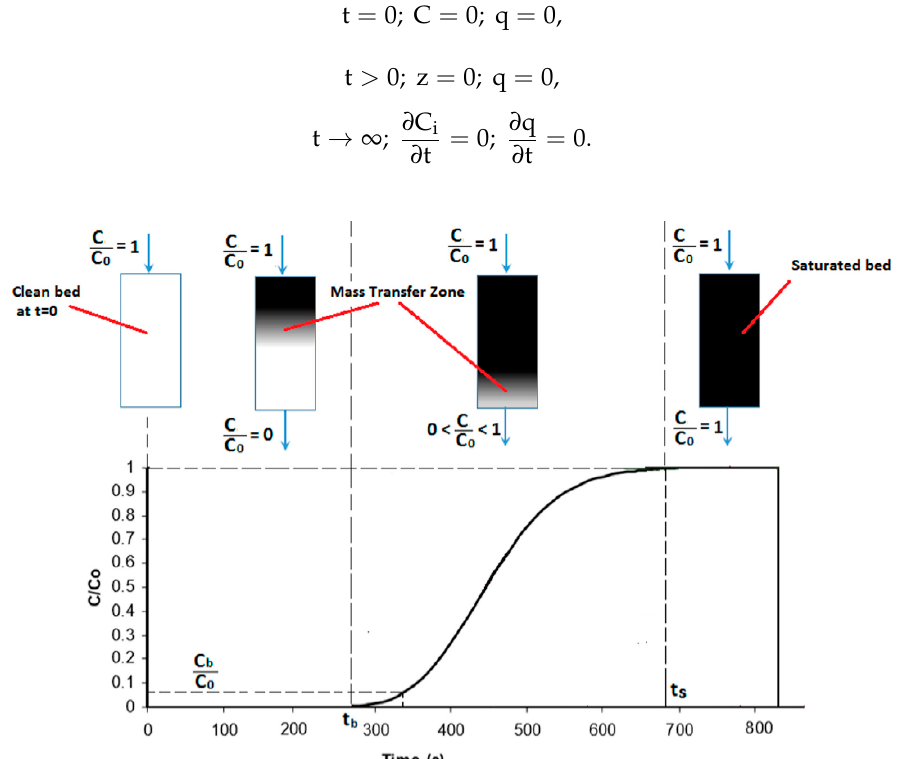
Figure 9. Typical breakthrough curve (C b = breakthrough concentration; C o = feed concentration; t b = breakthrough time; t s = saturation time.) (Reprinted from [151] with permission from Elsevier, 2017).